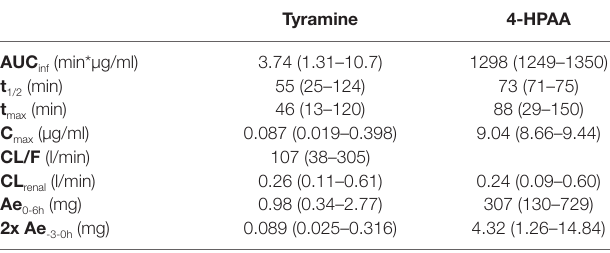
Data is given as geometric mean with the geometric 95% confidence interval in parentheses, except for t max , for which the median and the range is given; n = 88. Baseline amount excreted (Ae -3-0h ) data were multiplied by 2 for better comparison to the 6 h post-application measurement interval.